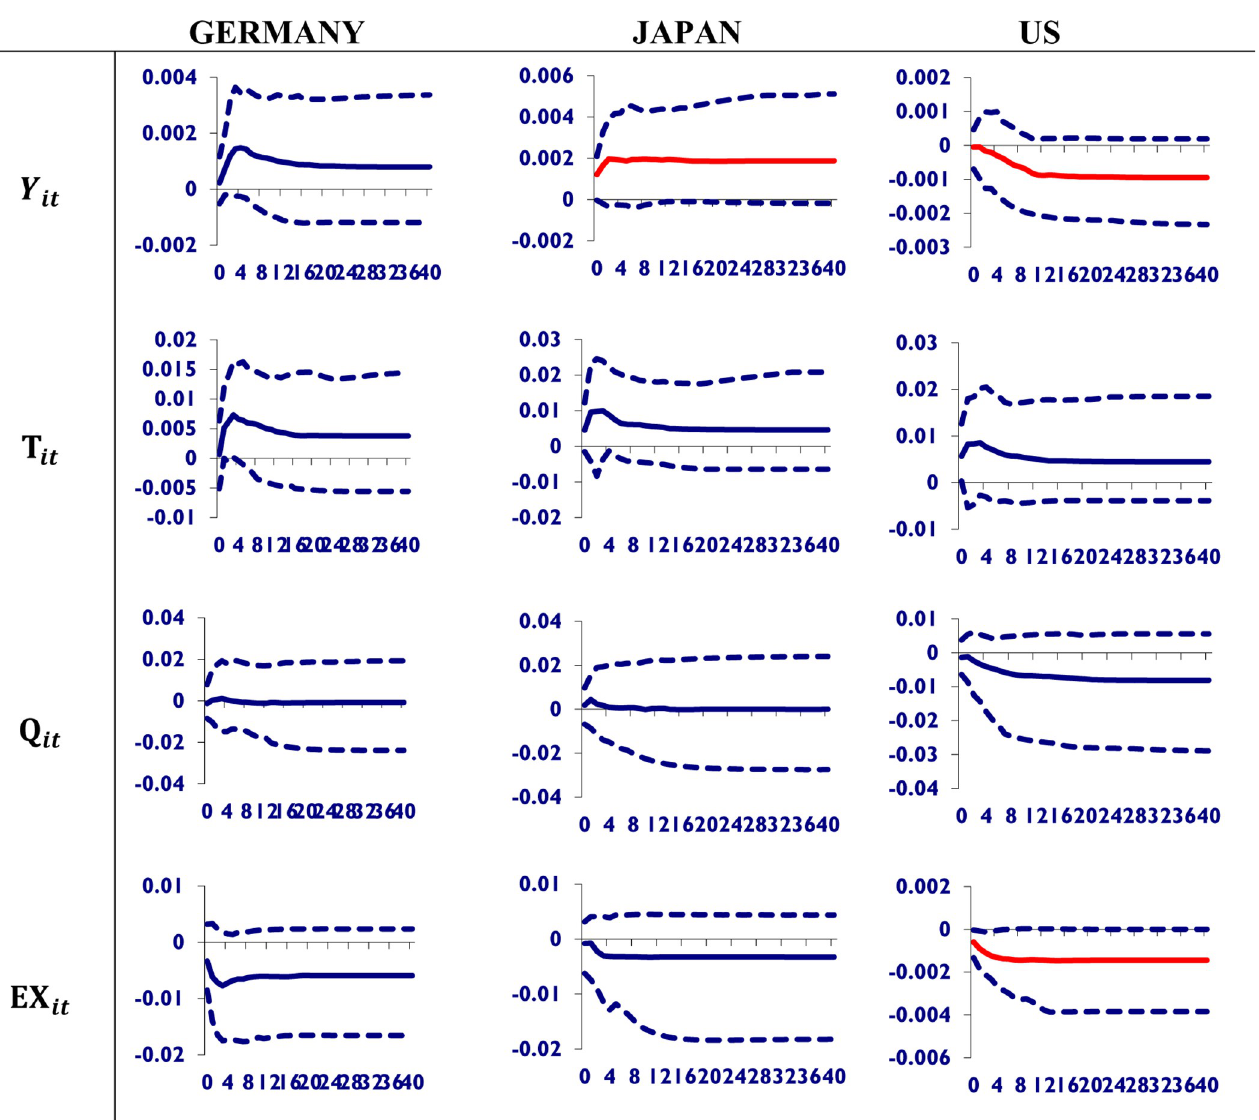
Fig 2. Shocks to Chinese real GDP and its impact on trading partners. A shock to Chinese real GDP has an insignificant impact on the macroeconomic variables of Germany. Japan will enjoy the shock of Chinese GDP by improving its own. However, it appreciates the US currency only among its macroeconomic variables and will worsen its